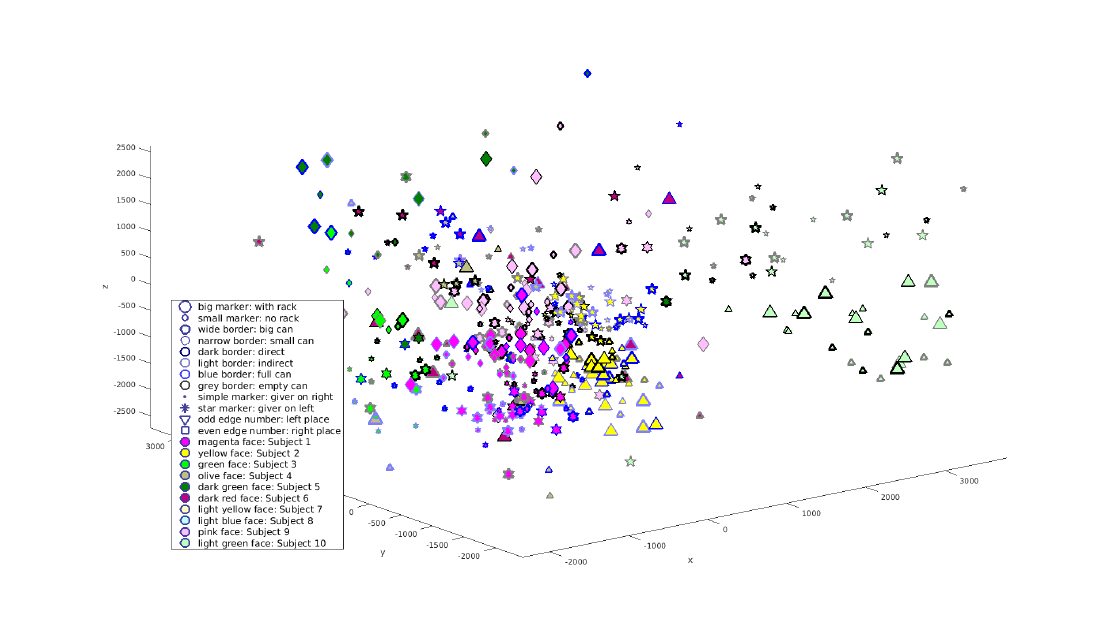
Figure 5. Results of the multidimensional scaling into three dimensions for all participants except “Subject 7” and “Subject 8”. The axes of the three-dimensional projection space are labelled with x , y and z . Each trajectory is represented by one marker in this space. Different experimental conditions are symbolized by different marker limits, and different participants by different colours of the markers, as described in detail in the legend.